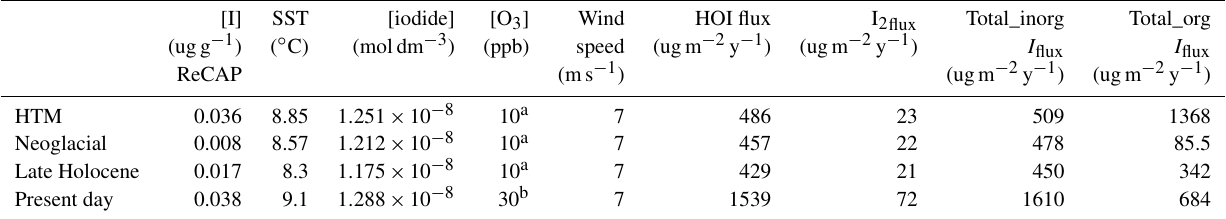
a Values obtained from Volz and Kely (1988). b Values obtained from MERRA reanalysis dataset.